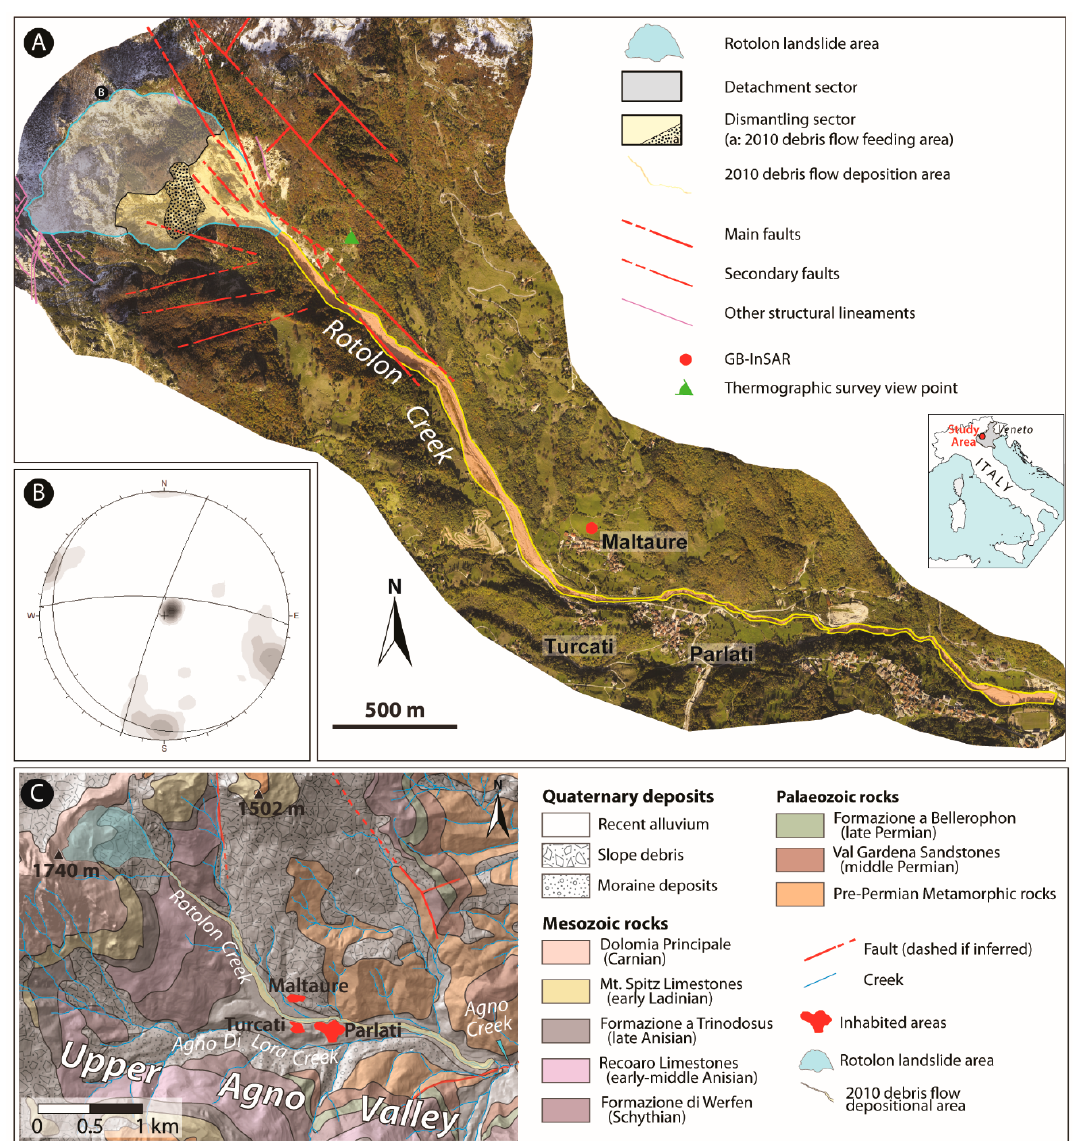
Figure 1. ( A ) The Rotolon creek valley and the main structural lineaments (modified from [15]); ( B ) Plot diagram showing the horizontal attitude of the bedding (central pole) and geometry of two joints systems that are NNE-SSW and E-W oriented (modified from [15]). Data were collected along the ridge above the crown, as shown in ( A ); ( C ) Geological sketch map of the upper Agno River valley with the location of the Rotolon deep-seated gravitational slope deformations (DSGSD) (modified from [25]).